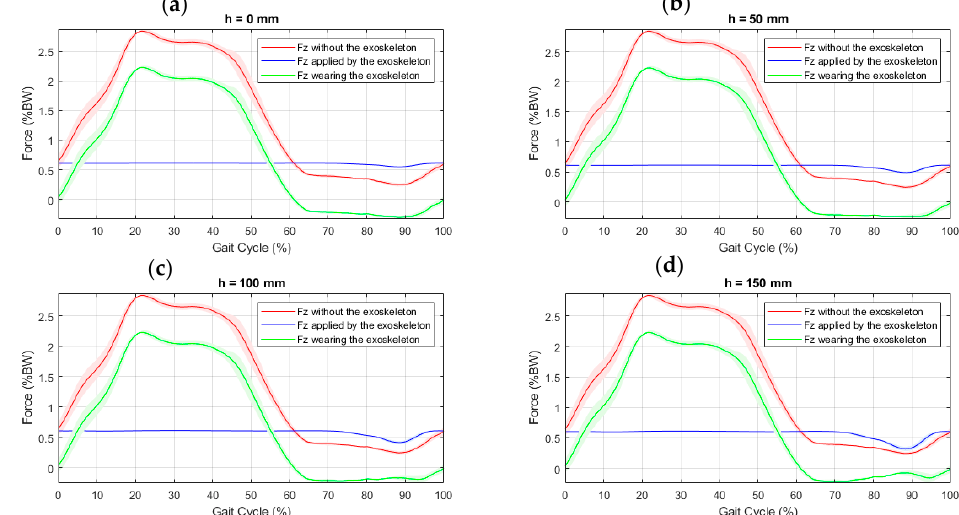
Figure 7. Study of the behavior of the system as a function of the distance h for k = 5 N/mm: ( a ) h =0 mm; ( b ) h =50 mm; ( c ) h =100 mm; ( d ) h =150 mm. “Fz without the exoskeleton” is the force applied to the hip in a normal daily gait without wearing the exoskeleton, “Fz applied by the exoskeleton” is the absolute value of the longitudinal force exerted by the exoskeleton, and “Fz wearing the exoskeleton” is the longitudinal force applied to the hip while using the exoskeleton, i.e., the “Fz without the exoskeleton” minus the “Fz applied by the exoskeleton”. Once again, based on the obtained results, the dependence of the dual behaviour from the distance h can be observed.